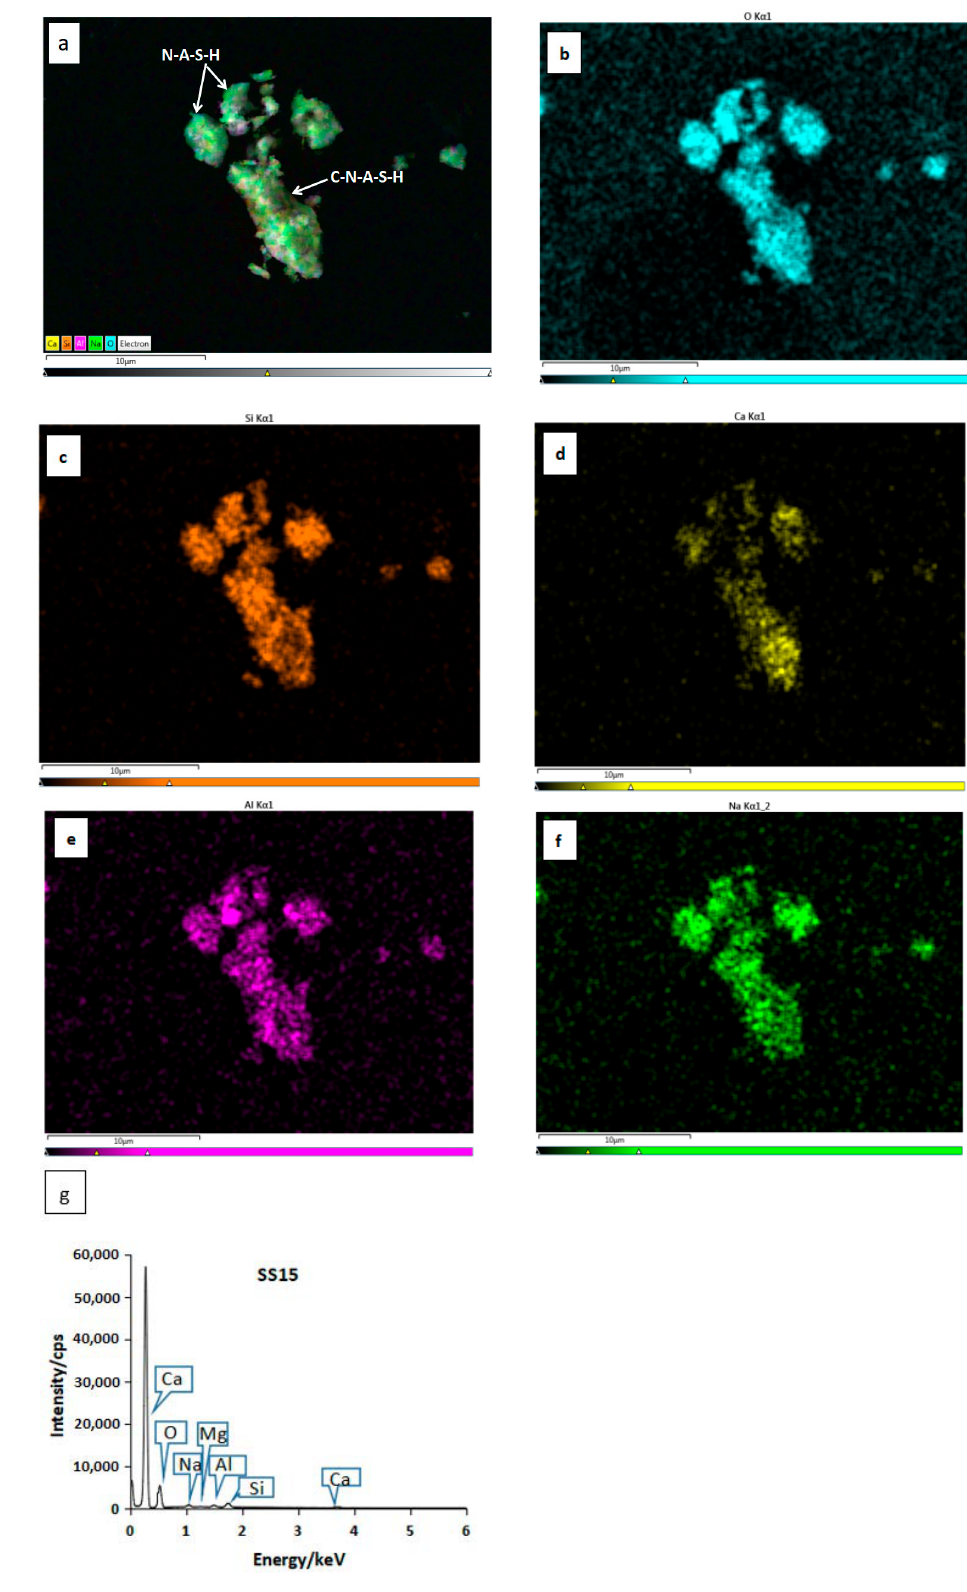
Figure 16. Element distribution diagram and EDS spectrum of SS15. ( a ) General distribution of major elements, ( b ) O element, ( c ) Si element, ( d ) Al element, ( e ) Na element, ( f ) Ca element, ( g ) EDS spectrum.